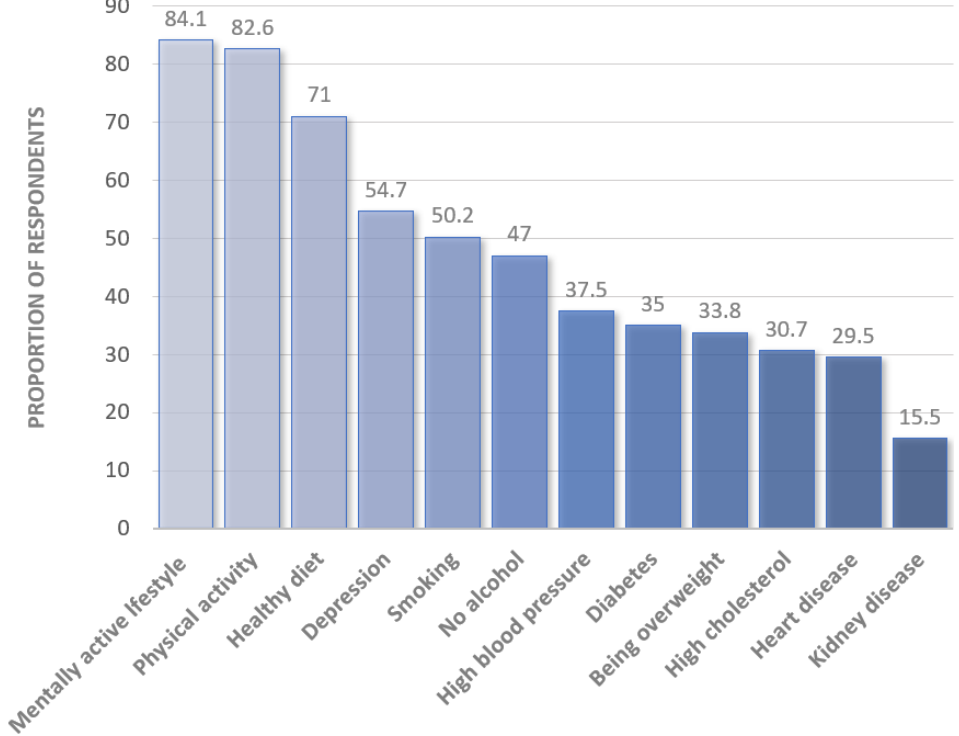
Figure 2. The proportion of respondents who correctly identified actual modifiable dementia risk factors.